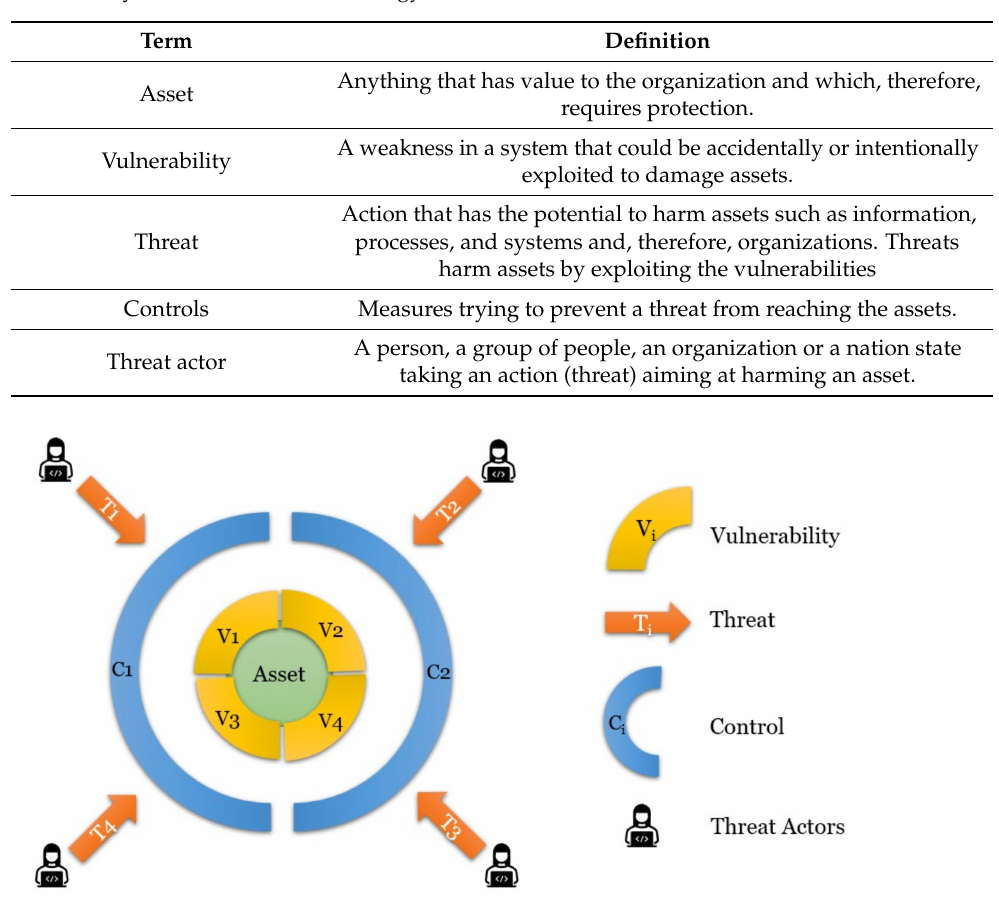
Figure 2. Interview questionnaire. Table 2. Key risk assessment terminology.